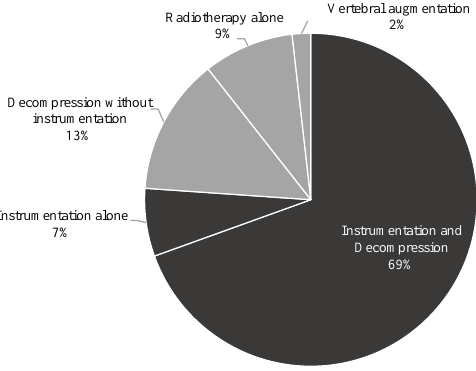
Figure 1. Treatment modalities in the study cohort.